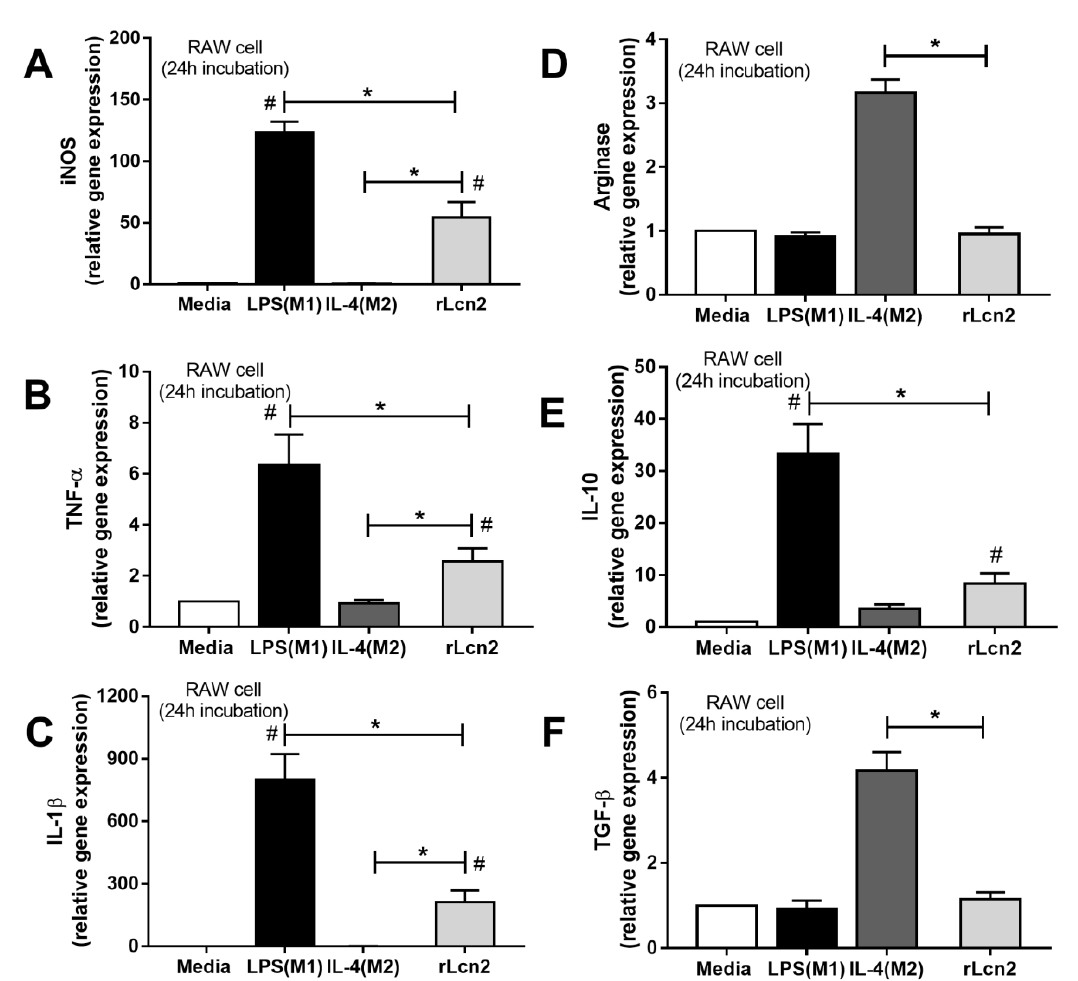
Figure 5. The evaluation of macrophage polarization after incubation with LPS (M1 induction), IL-4 (M2 induction), recombinant Lcn-2 (rLcn-2) and media control (Media) in RAW264.7 cell as determined by relative mRNA expression in markers of M1 ( iNOS , TNF- α and IL-1 β ) ( A – C ) and M2 polarization ( Arginase-1 , IL-10 and TGF- β ) ( D – F ) was demonstrated. (Independent triplicate experiments were performed for all experiments; *, p < 0.05).